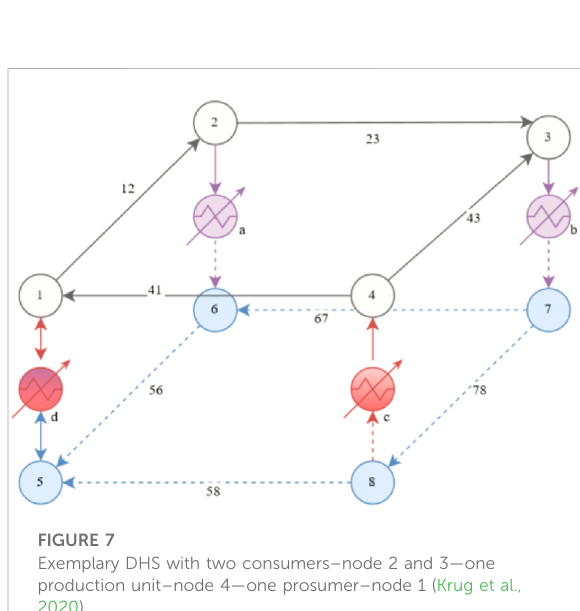
FIGURE 7 Exemplary DHS with two consumers – node 2 and 3 —